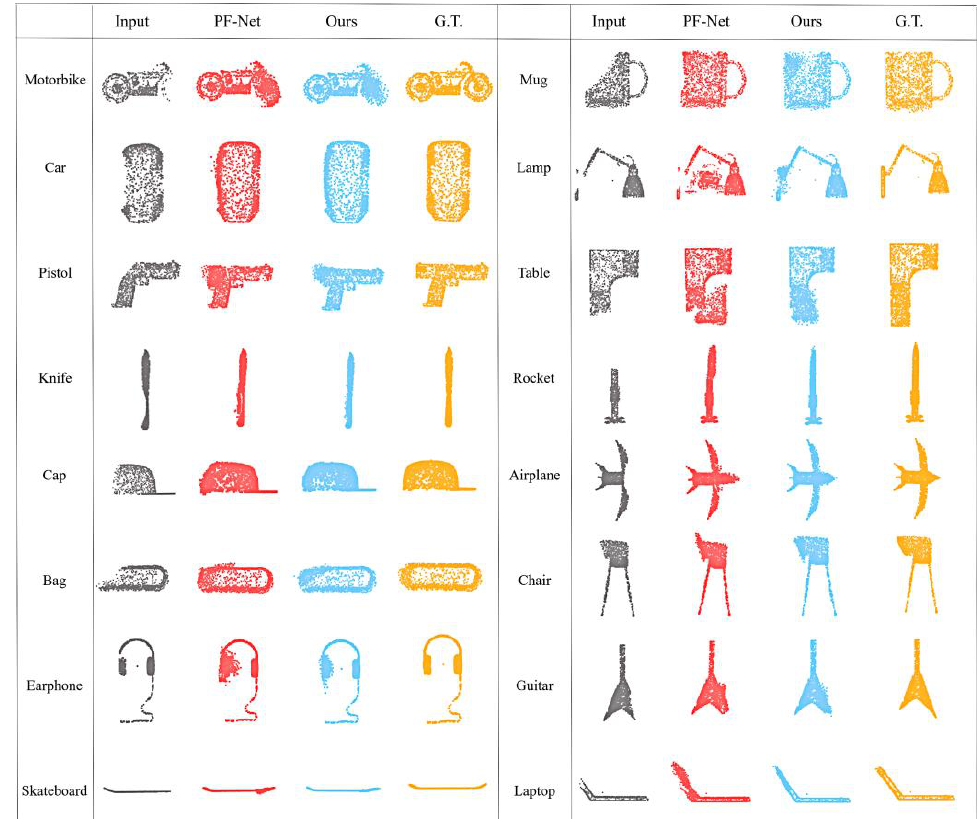
Figure 6. Qualitative results on ShapeNet-16 showing the input point cloud (Input) and the ground truth (G.T.), and the predictions of PF-Net and our model.